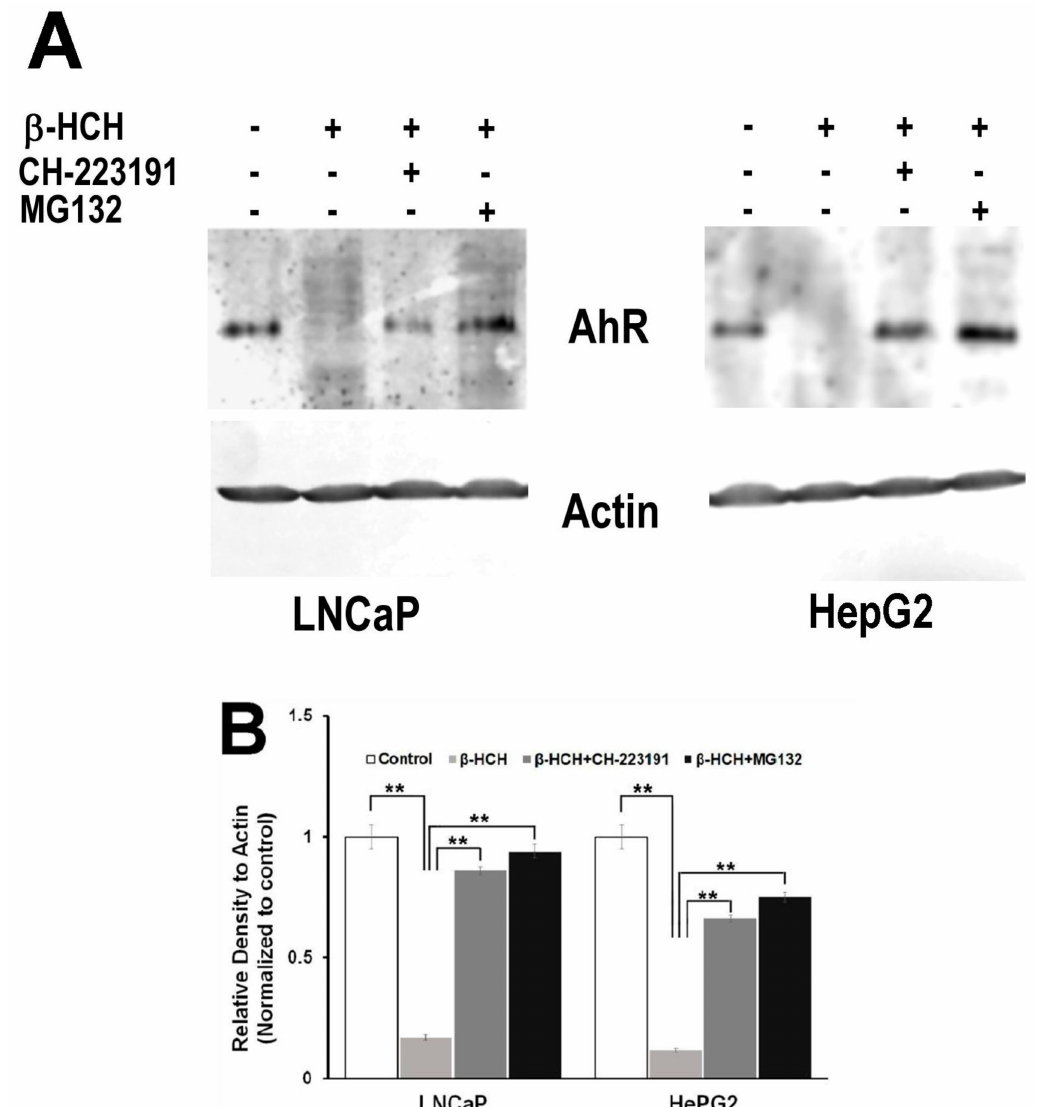
Figure 7. AhR proteasomal degradation is induced by β -HCH in both LNCaP and HepG2 cells. ( A ) Total protein extracts were subjected to Western blot analysis. Samples obtained from cells treated with 10 µ M β -HCH alone exhibit a weaker signal compared to the samples from cells treated with both the inhibitors. The 2 h pretreatment step with 2 µ M MG132 or 150 nM CH22131 is able to maintain AhR at the same levels as the control. ( B ) Quantification of protein levels by densitometric analysis. Values for each sample were normalized against the β -actin level present in the same sample and taken as a housekeeping control. The experiment was repeated three times and a representative blot is reported. Statistically significant di ff erences (** p < 0.01) are marked with